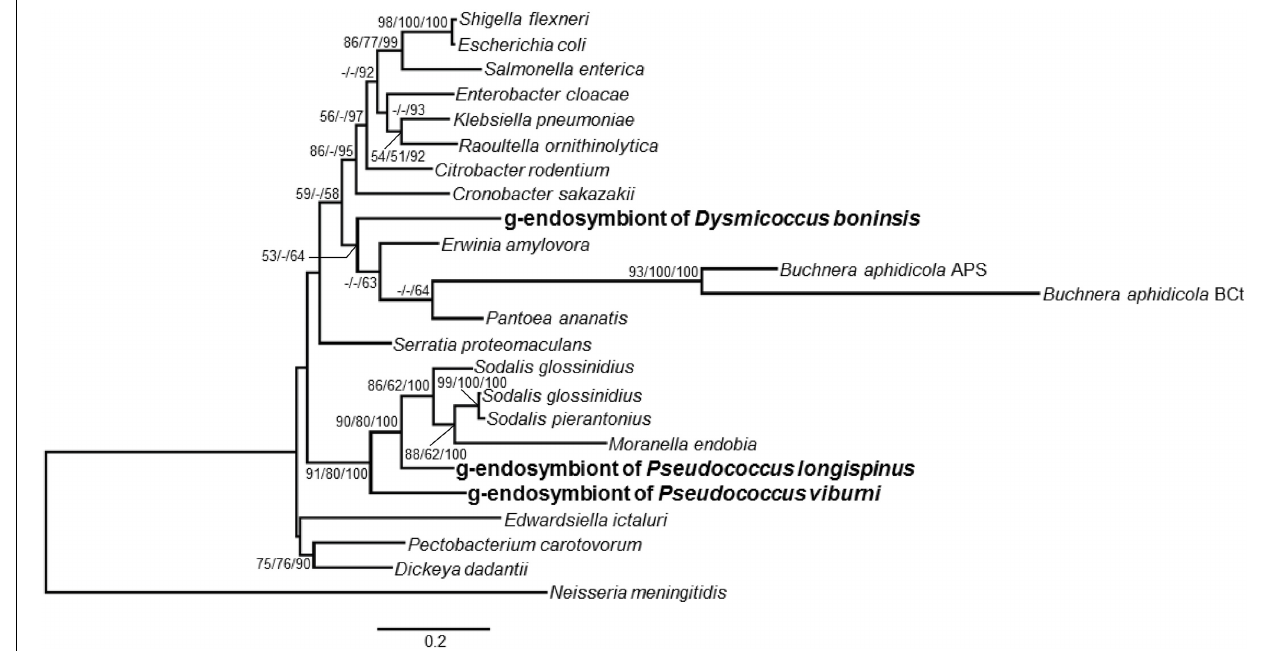
FIGURE 8 | Phylogenetic relationships among gamma-endosimbionts of mealybugs from subfamily Pseudoccinae , based on concatenated sequences of genes argH and trpB . Sequences obtained in this work are in bold. The betaproteobacterium Neisseria meningitidis MC58 was